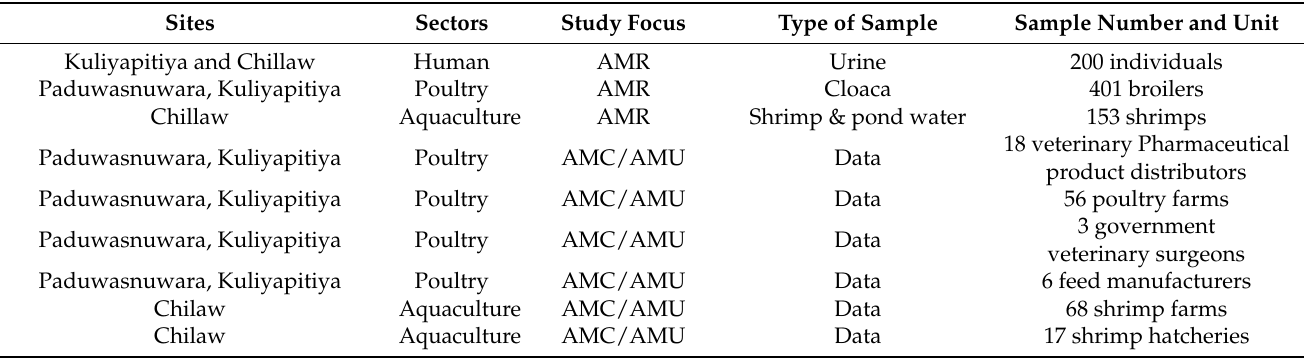
Table 5. Sector, sample types, sites, and number of samples collected from each sector during the study for AMR and